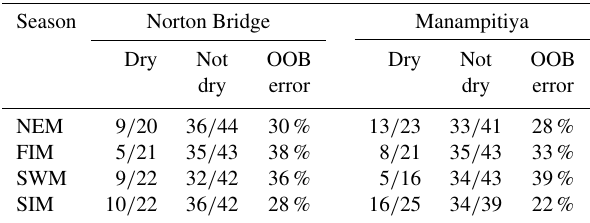
Table 4. Results of random forest ensemble classification results for two rainfall anomaly classes. Out-of-bag error (OOB) is the classi- fication error calculated from the data not used to fit the